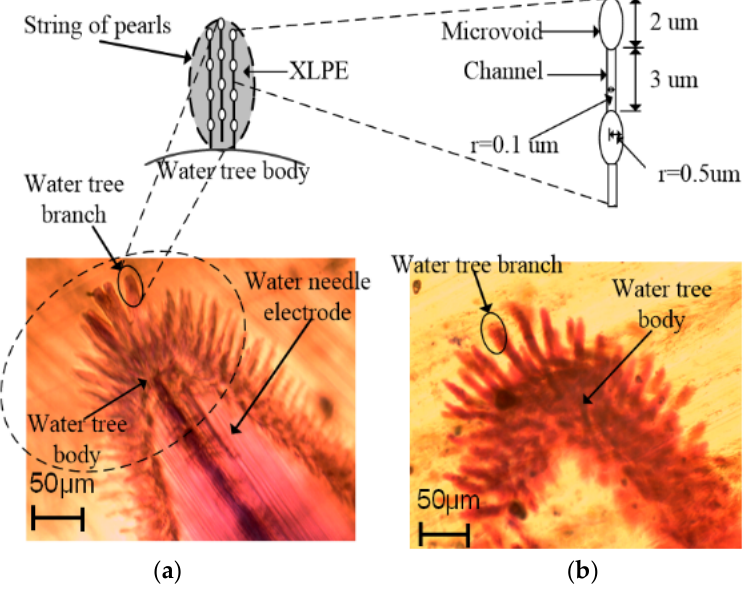
Figure 8. Water tree morphologies after one week and two weeks of water tree accelerated experiments at 20 °C: ( a ) After one week; ( b ) After two weeks. ments at 20 ◦ C: ( a ) After one week; ( b ) After two